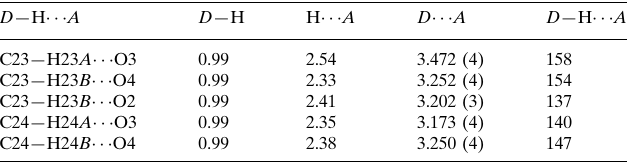
Hydrogen-bond geometry (A˚ , (cid:3)